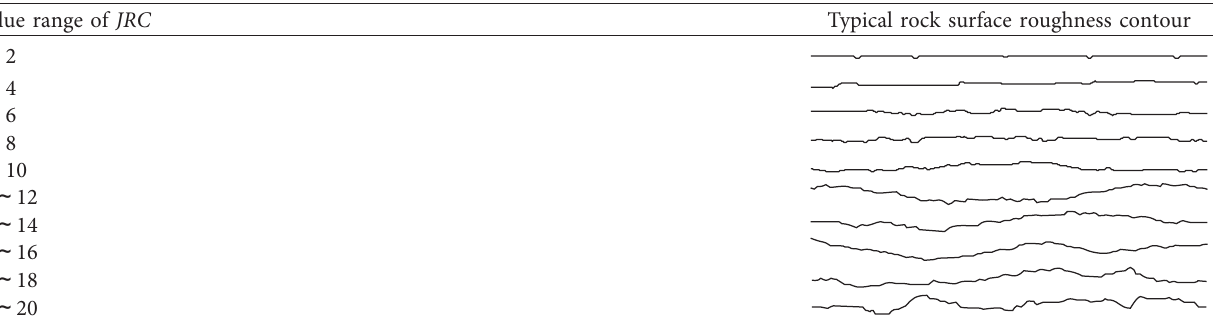
Figure 5: Edge and angle determination of the aggregate particles: (a) calculation of the surface curvature of the aggregate; (b) relationship between the triangular network model and the ring neighborhood. Table 3: Barton standard roughness